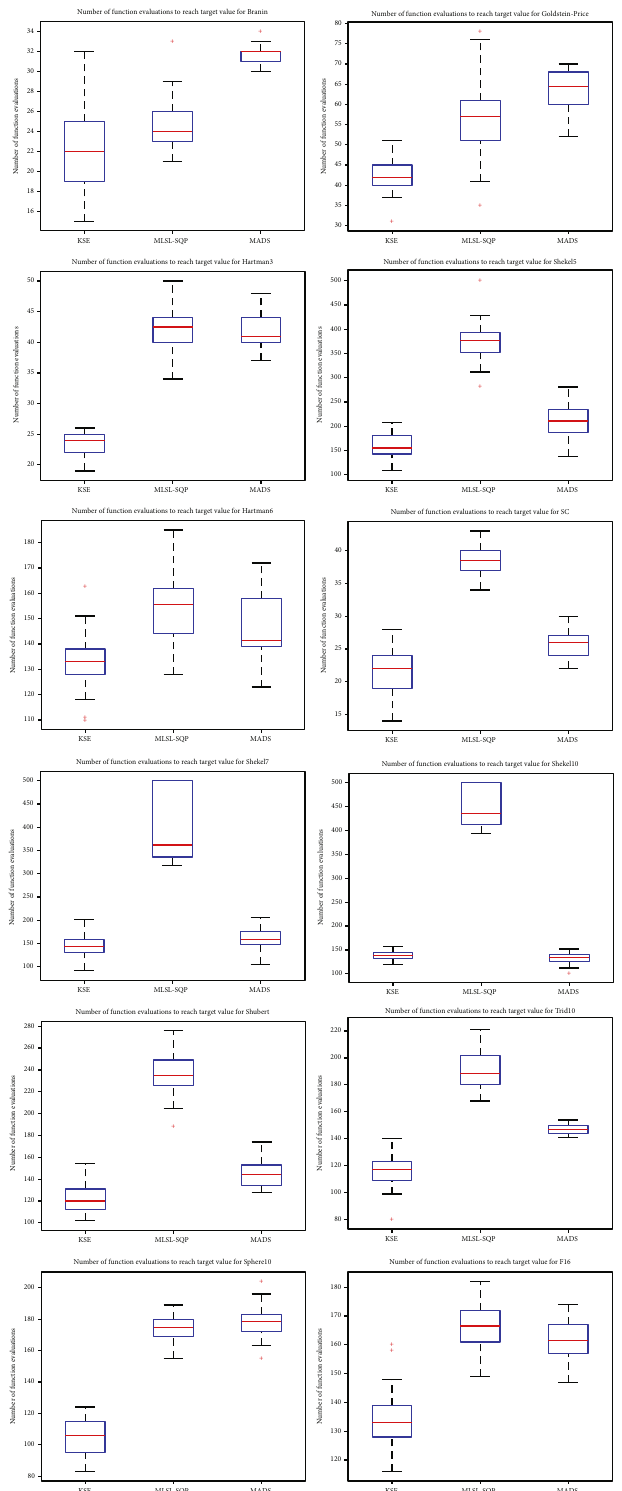
Figure 11: Box plot of the number of function evaluations to get within 1% of the target